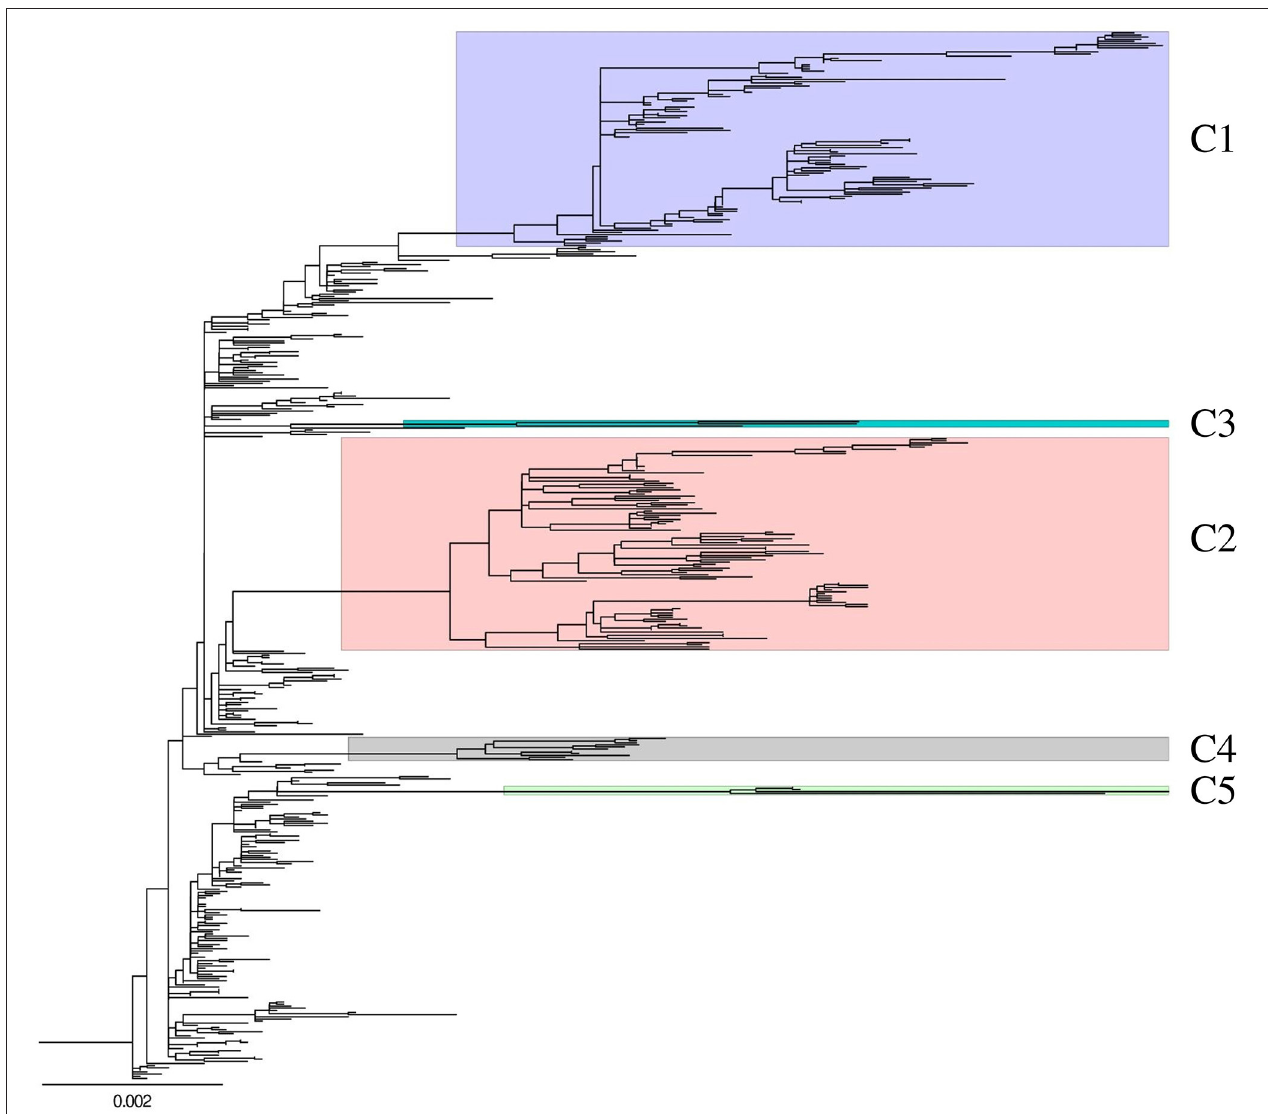
FIGURE 1 | Genetic characterization of H5N8 high pathogenicity avian influenza isolated in South Korea during 2014–2016. Maximum-likelihood phylogenetic tree of concatenated complete genome sequences. Whole genome sequences of 493 H5N8 high pathogenicity avian influenza viruses collected from 388 birds on domestic poultry farms and 105 wild birds between January 2014 and April 2016. Labels and highlights indicate genetic subgroups. C3 cluster had strains isolated from wild bird in only Japan. Non-labeled and highlighted viruses are belonged to subgroup C0. Phylogenetic analyses were performed with RAxML version 8.2.12 using a gamma distribution and a general time-reversible